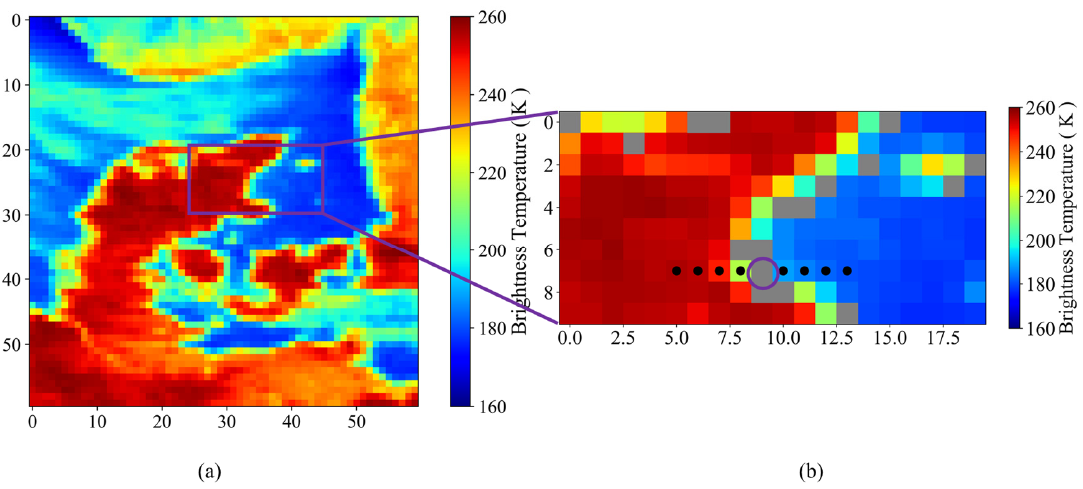
Figure 3. The distribution of FY ‐ 3D MWRI brightness temperature of Denmark ( a ) acquired on 3 March 2018. ( b ) shows a zoom area in Aalborg Bugt, Denmark overlaid with the coastline point data. The highlighted gray pixels ( b ) represent the locations of the coastline pixels from LandSea ‐ Mask. The data are displayed in the swath coordinate system.